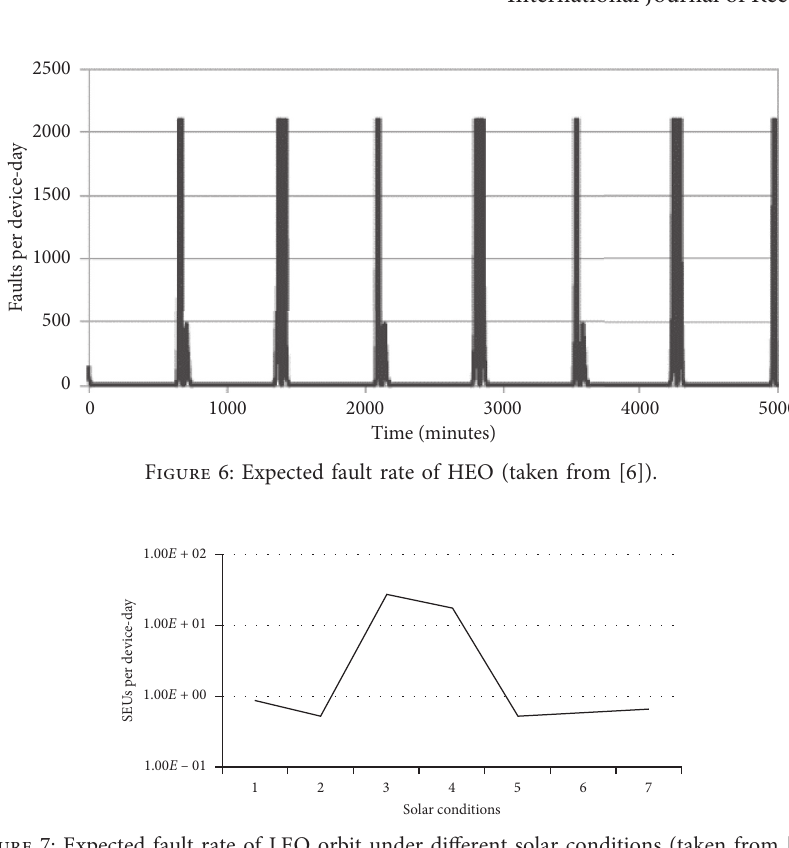
Figure 7: Expected fault rate of LEO orbit under different solar conditions (taken from